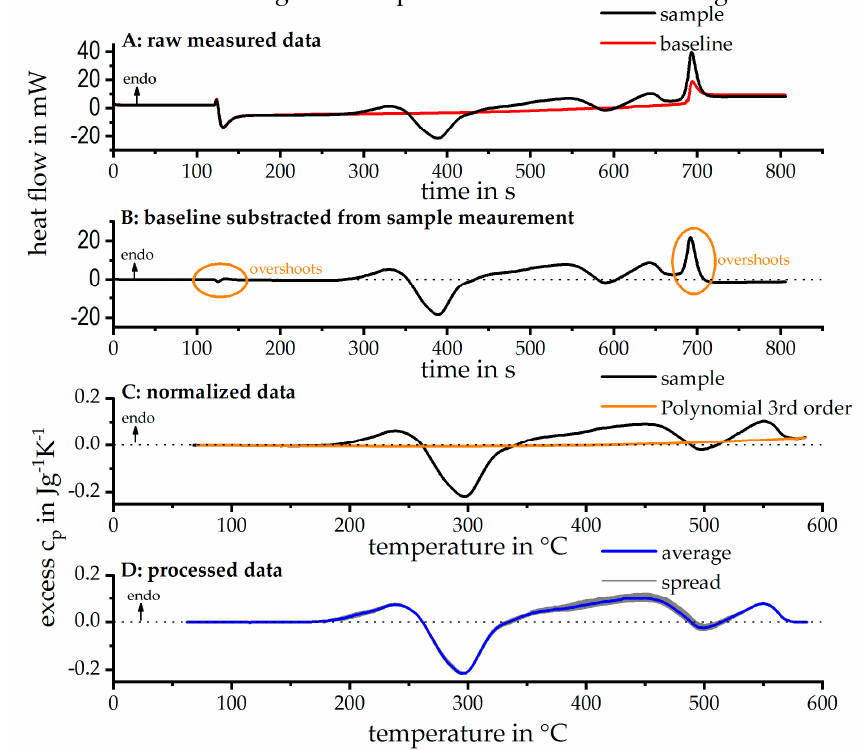
Figure 4. Raw data treatment of DSC heating experiments. ( A ) Raw heat flow measurement data; ( B ) subtraction of baseline measurement from the sample measurement; ( C ) normalization of the data; ( D ) processed data ready for discussion.